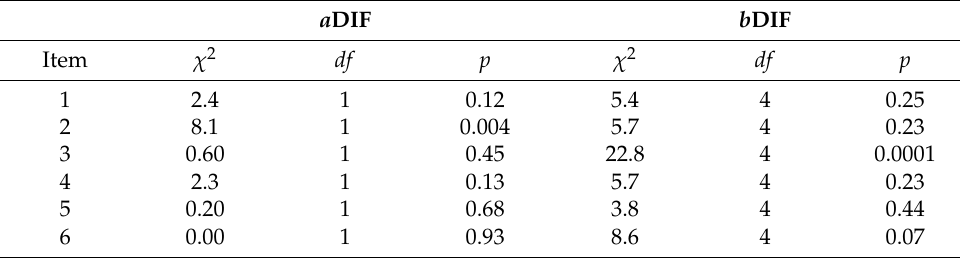
Table 4. Differential item functioning (DIF) of discrimination and severity parameters across age. a DIF b